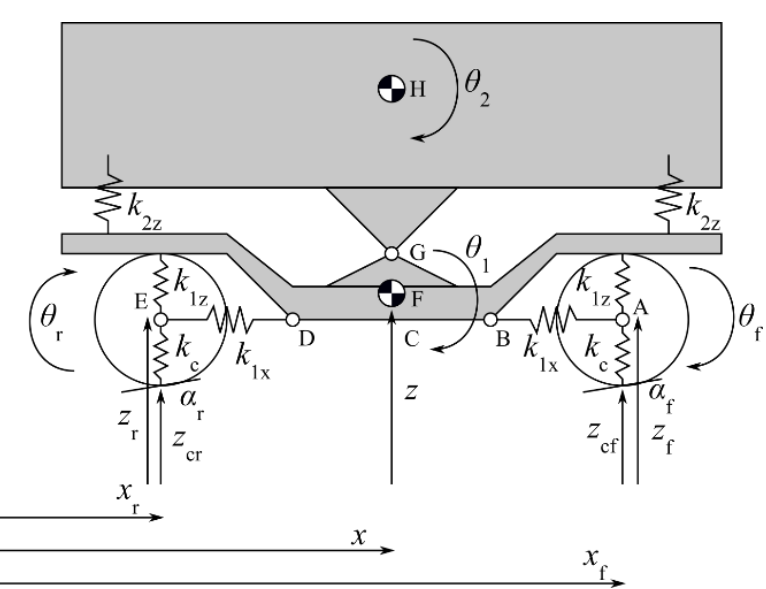
Figure 6. Scheme of the vehicle model, highlighting connections between bodies and the adopted degrees of freedom.